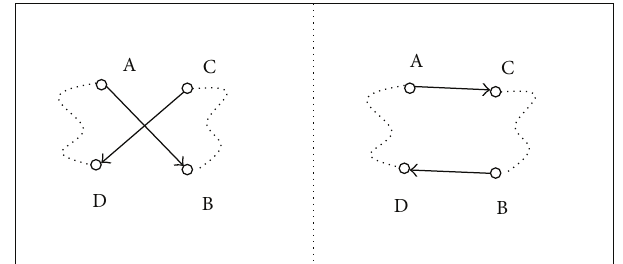
Figure 4: The schematic diagram of ACO-SLC. Firstly, classify all points into compact classes. Secondly, the centroid of each class is regarded as a virtual city. And calculate a virtual TSP route. Then along the virtual route, join all classes. Thirdly, let ACO act on each class to get a local TSP route. Fourthly, join all local TSP routes along the virtual route to form the last route. The illustration of removing cross-edges from TSP route: at the left figure, AB and CD intersect eachother. Thereisaprinciplethattheshortestrouteisatthesurface of a convex hull. Thus, edges AB and CD are the longer part of route and should be removed. Removing these two edges will generate shorter route (see right